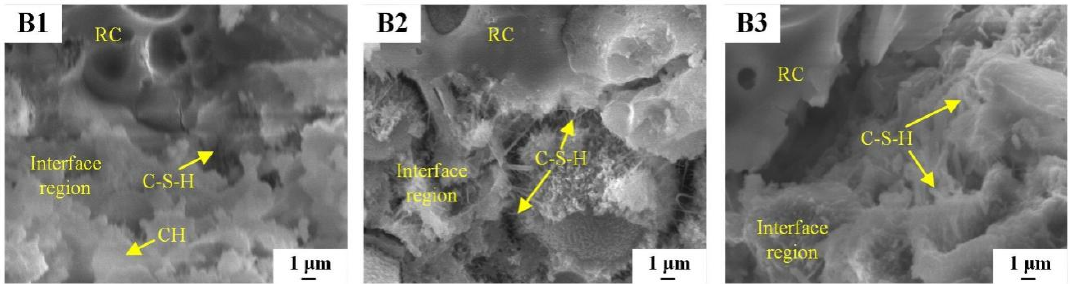
Figure 10. The high magnification SEM images of arched shell interface transition zone in specimens B1–B3 after 28 days curing time.